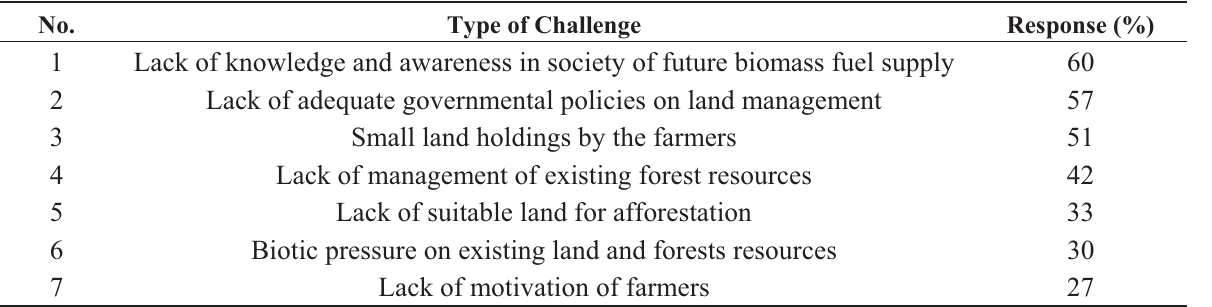
Table 3. Main challenges for production of wood biomass on government (other than waste lands) and private owned uncultivated lands ( N =